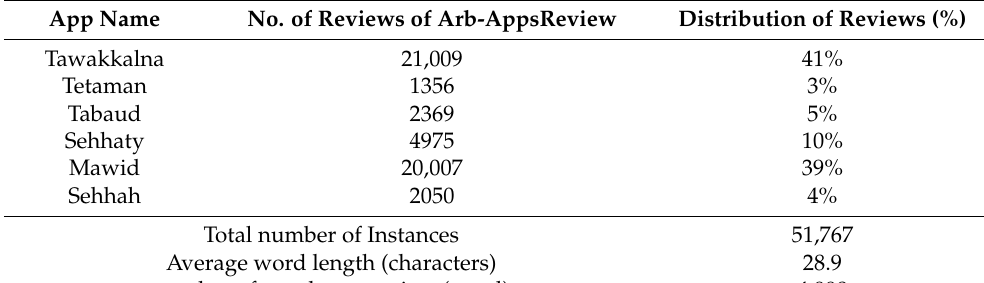
Table 1. Statistics of the Arb-AppsReview dataset.